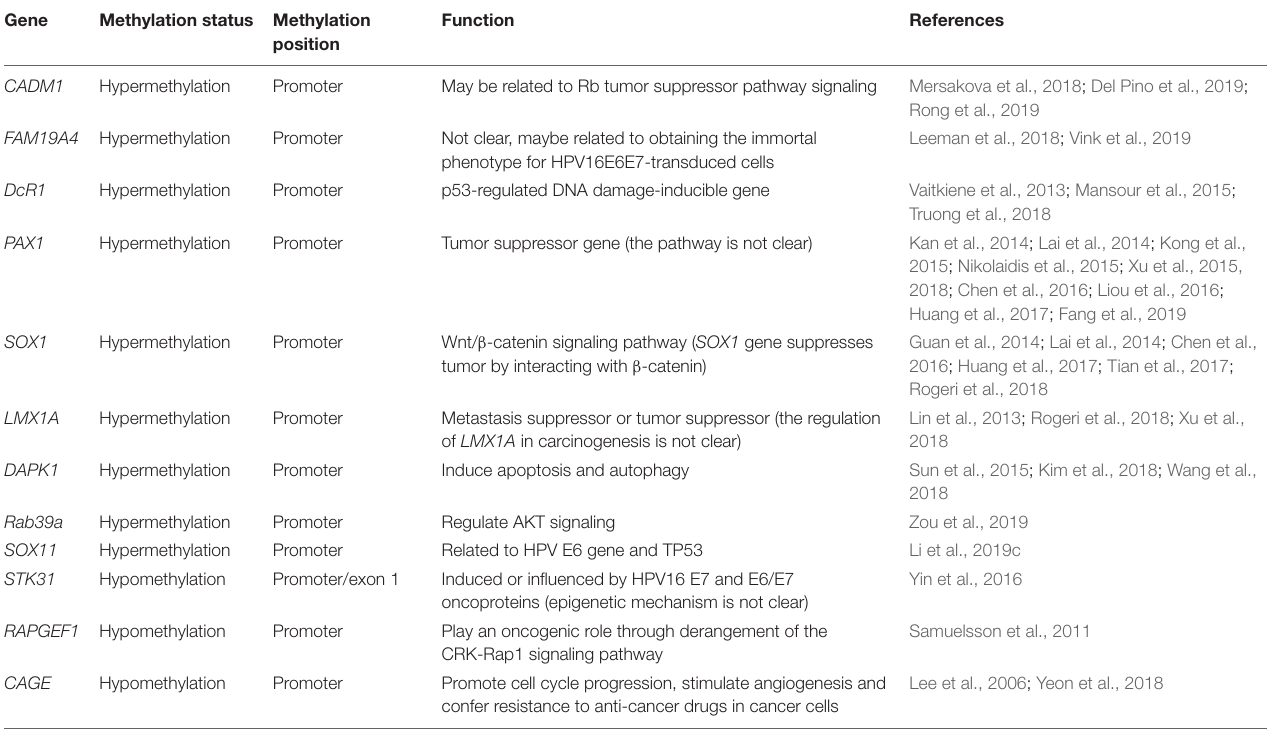
TABLE 1 | Potential biomarkers of DNA methylation in cervical